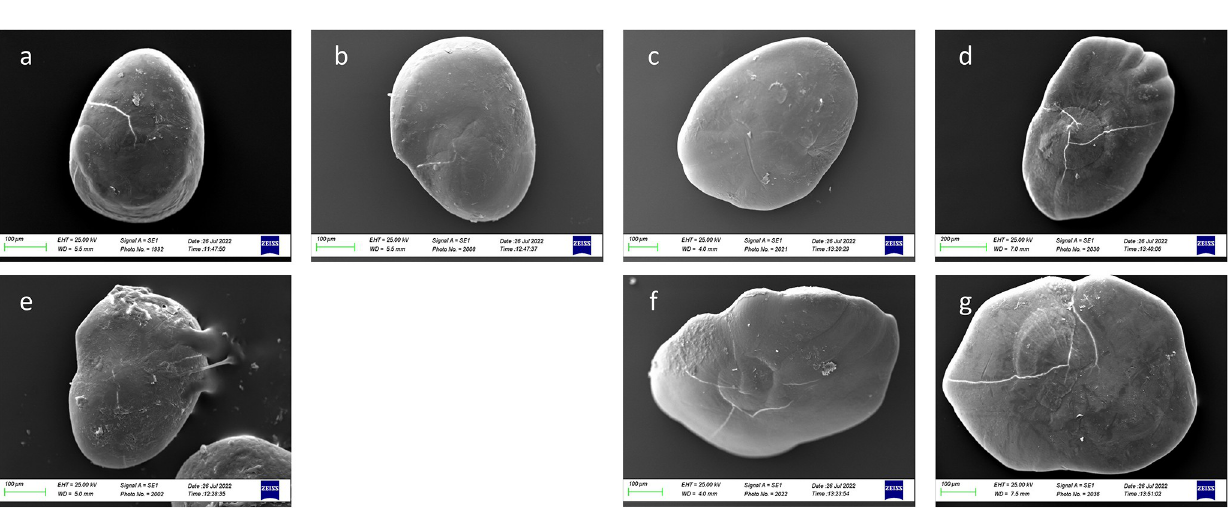
PLOS ONE | https://doi.org/10.1371/journal.pone.0281621 February 14,